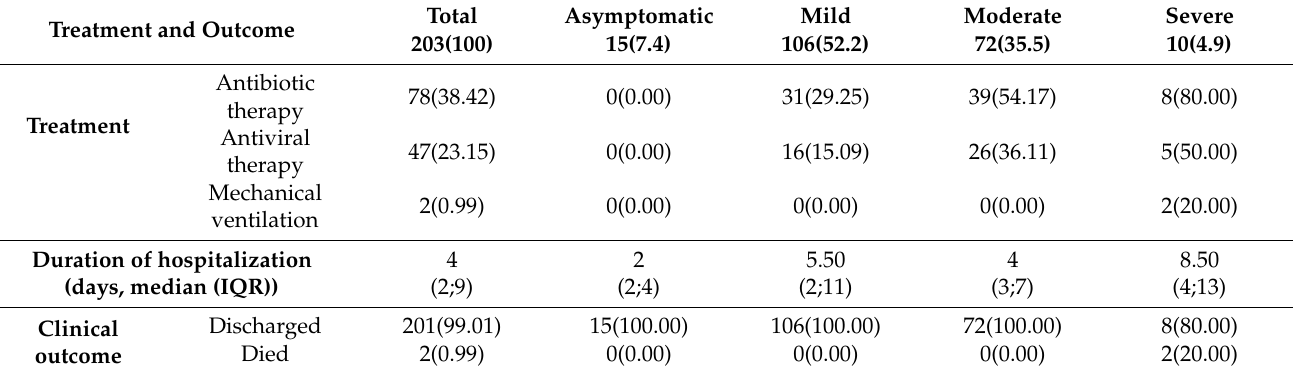
Table 3. Treatment and outcome of patients, stratified by clinical